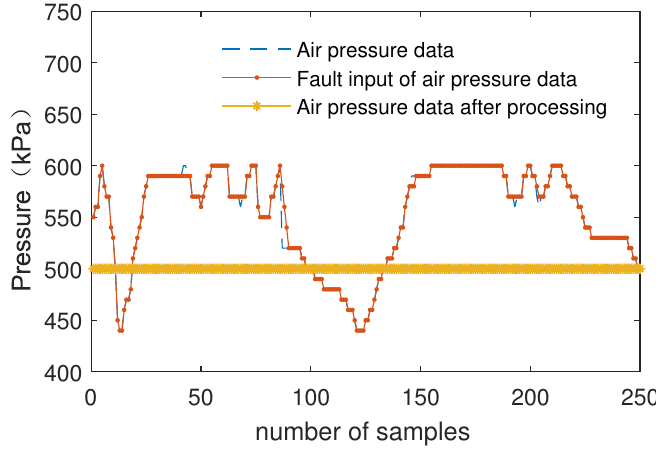
Figure 14. Air pressure data processing with one error